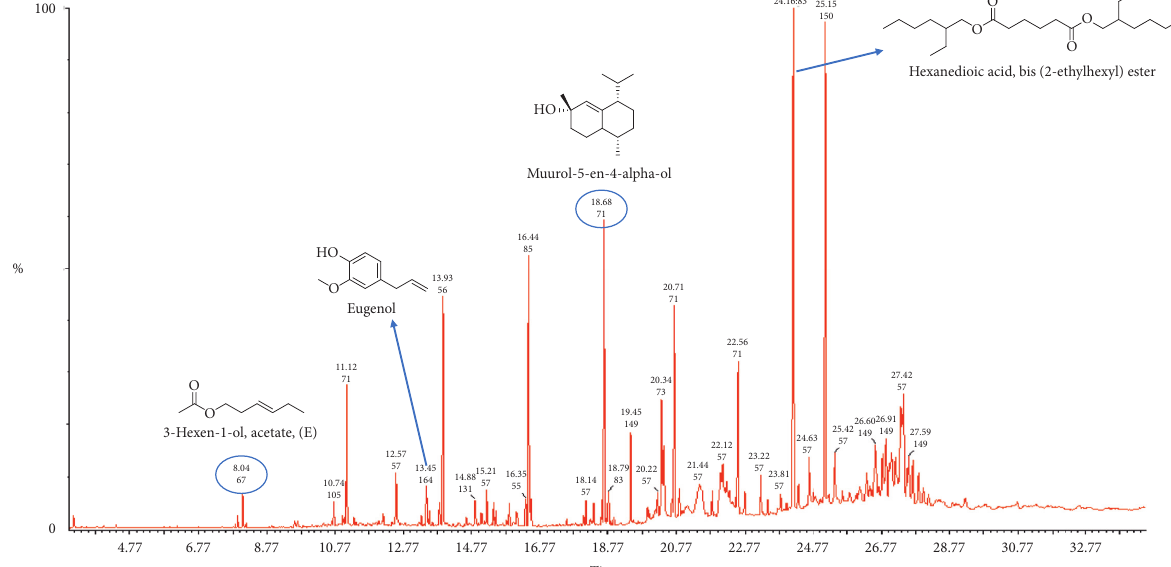
Figure 2: Total ion chromatogram (TIC) obtained from the GC-MS run of the essential oil from the fruits of Chrysophyllum albidum . Compounds were identified by comparison of MS spectra data with NIST and Wiley libraries as well as published literature. Chemical structures of some of the peaks are shown and were drawn with